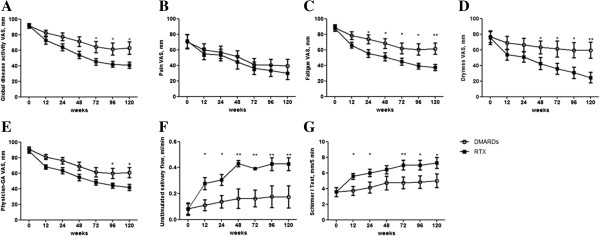
Clinical assessment in the rituximab and disease-modifying anti-rheumatic drug treatment groups. Clinical evaluation was performed as follows: (A) global disease activity visual analogic scale (VAS), (B) pain VAS, (C) fatigue VAS, (D) dryness VAS, (E) physician global assessment (GA) VAS, (F) unstimulated salivary flow, and (G)Schirmer I test. Bars in the line charts indicate mean ± standard error of the mean. **P <0.01 and *P <0.05, comparison between the two treatment arms at the corresponding time point. DMARD, disease-modifying anti-rheumatic drug; RTX, rituximab.